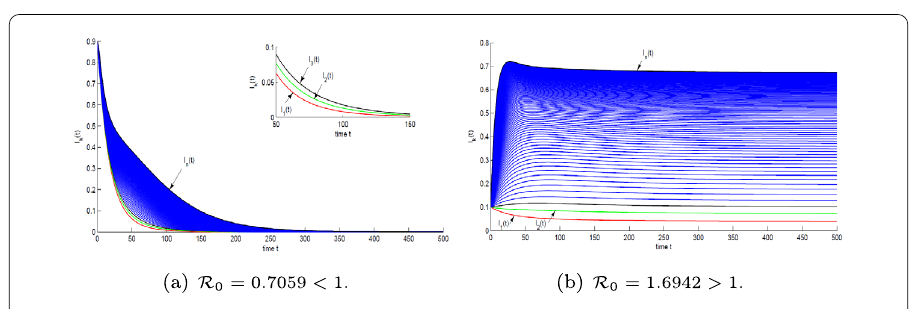
Figure 2 The time evolution of I k ( t ) for k = 1,2, ... , n from bottom to